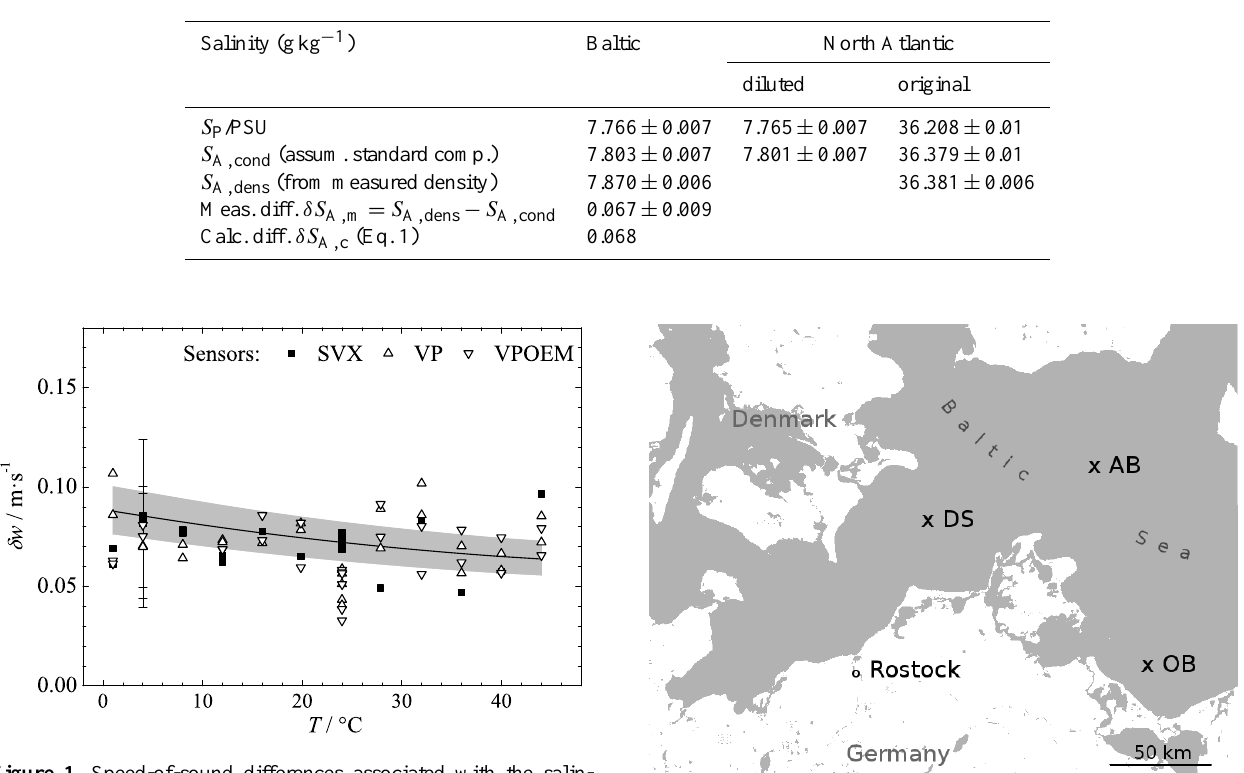
Figure 1. Speed-of-sound differences associated with the salin- ity anomaly for Baltic seawater at S P = 7.766. Symbols: measured differences from the Baltic and the diluted Atlantic sample (NA II) with virtually the same S P . Uncertainty bars are exemplar- ily given at 4 ◦ C. Line: δw calculated as w TEOS10 (S A,dens , T , p 0 ) − w TEOS10 (S A,cond , T , p 0 ) . The shaded area denotes the un- certainty range due to the salinity uncertainty.